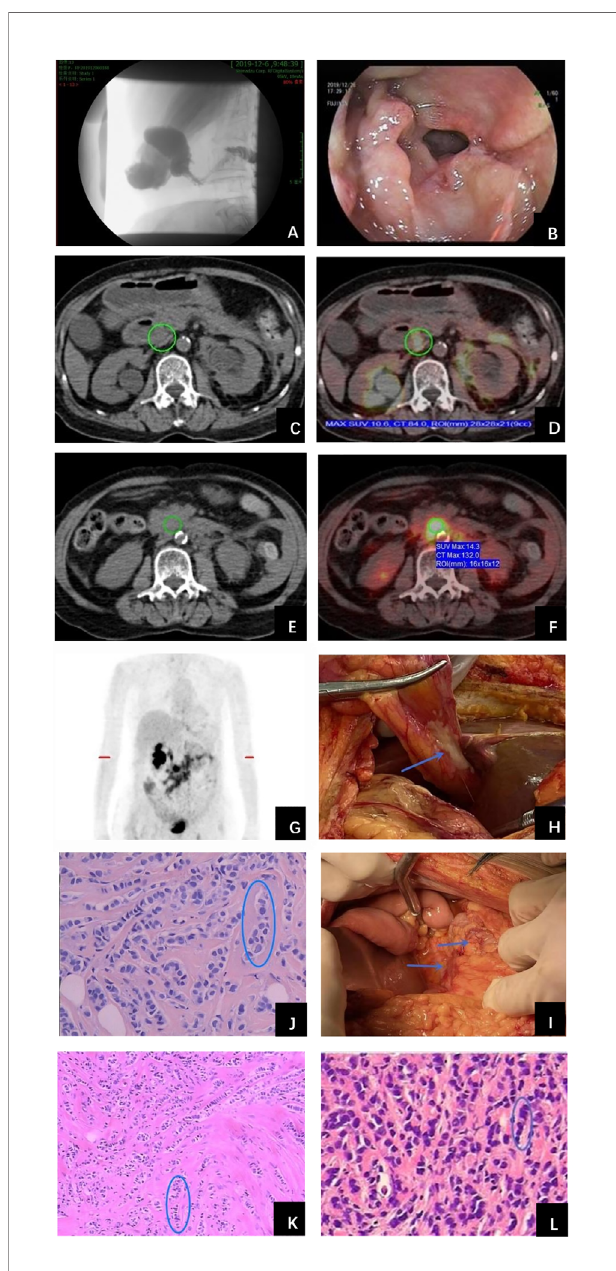
FIGURE 1 | Examinations and histopathological results during work-up of the patient. (A) Upper gastrointestinal X-ray showed a stricture in the second portion of the duodenum. (B) Upper gastrointestinal endoscopy detected a stricture with circumferential edematous friable mucosa, extending from the duodenal bulb to the second portion of the duodenum. (C) PET/CT revealed duodenal wall was thickened and identi fi ed as metabolically active lesions (SUVmax=10.6) (D) . (E) Thickened peritoneum and mesenteries and slightly larger lymph nodes in the mesenteries were found with intense FDG uptake (SUVmax=14.3) (F) . (G) Holistic view of PET/CT: metabolic lesions in the duodenum, peritoneum and mesenteries. Exploratory laparotomy showed three metastatic nodules in the peritoneal cavity, including one nodule on the ligamentum teres hepatis (H) and the other two on the omentum (I) (arrows). Histopathological examination of primary breast cancer (J) , metastatic axillary lymph node (K) and metastatic peritoneal nodule (L) all revealed single- fi le strands of in fi ltrating small tumor cells dispersed in the fi brous matrix